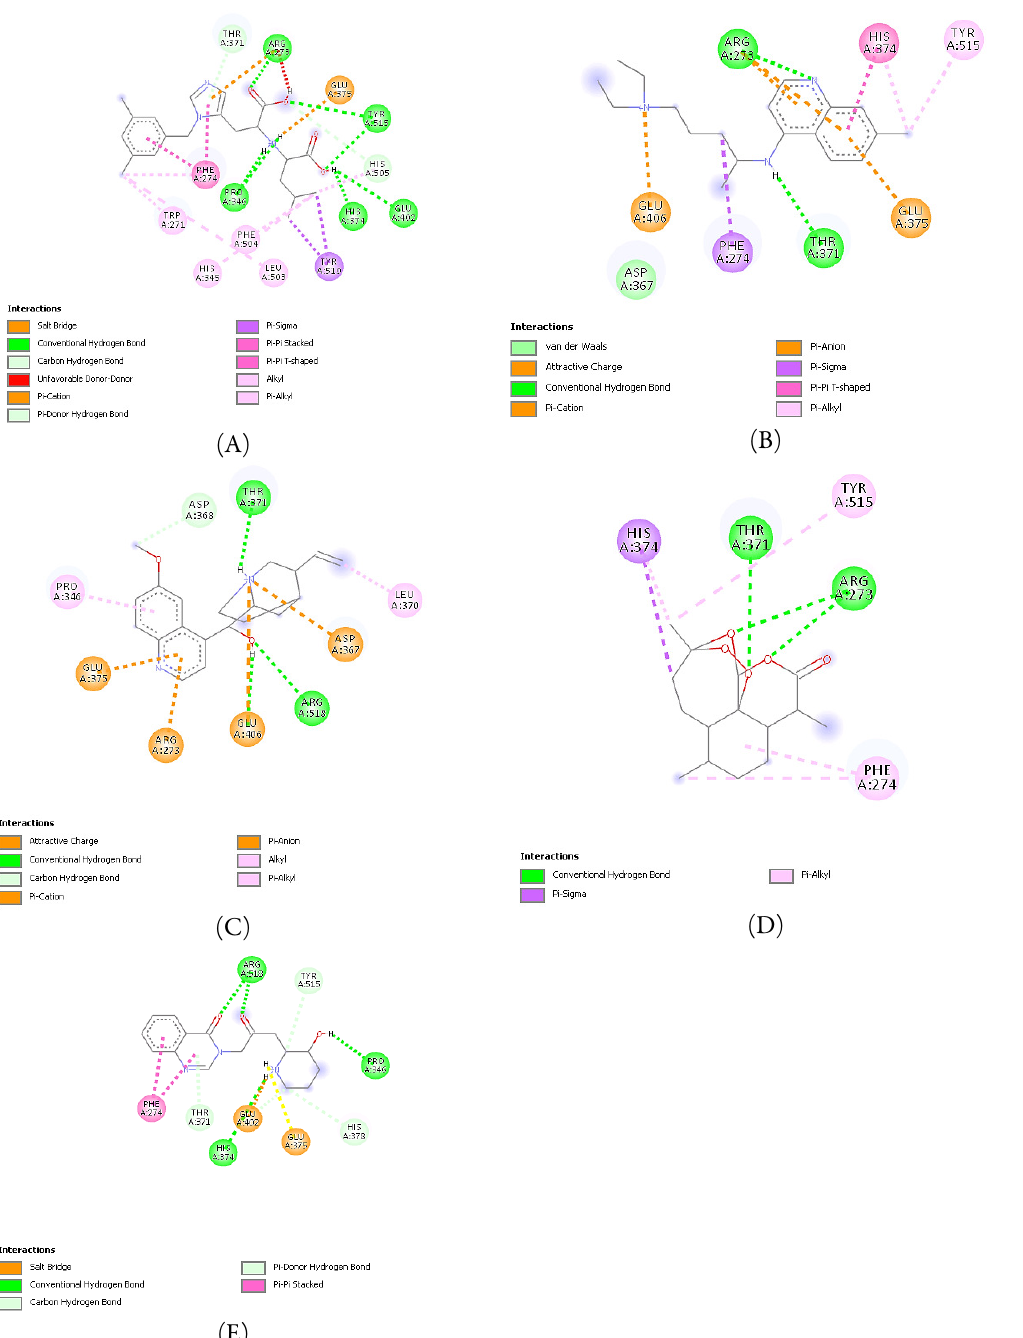
Figure 3. Depiction of 2D structures showing the interactions between the studied ligands and the receptor ACE2. A, Interactions between the reference molecule (XX5) and ACE2. B, Interactions between Chloroquine and ACE2. C, Interactions between quinine and ACE2. D, Interactions between artemisinin and ACE2. E, Interactions between febrifugine and